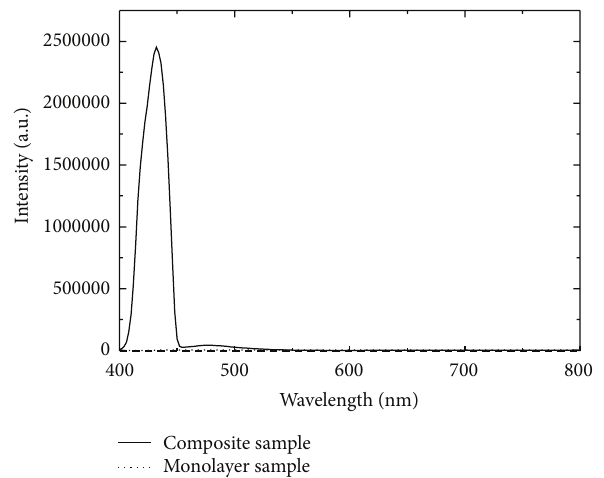
Figure7:Photoluminescenceemissionspectraofcompositesample (straight line) and monolayer sample (dotted line) at 300 nm.